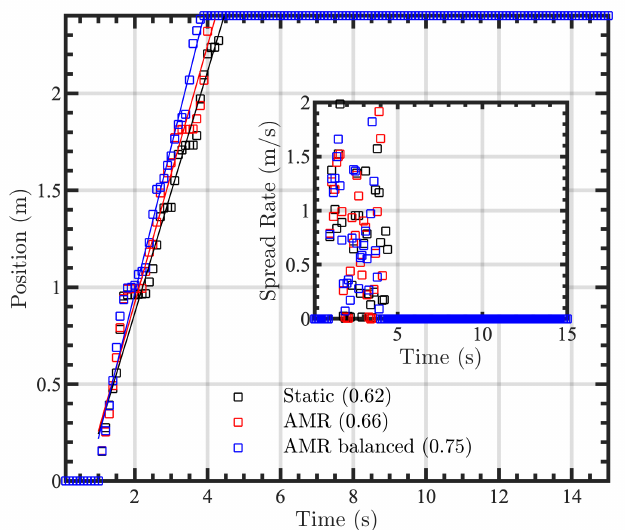
Figure 4. Comparison of fire spread and spread rate, shown in the inset as well as with least-squares fits, up the panel for the vertical fire spread verification test case in the static (black squares, black line), AMR without load balancing (red squares, red line), and AMR with load balancing (blue squares, blue line) simulations. The numbers in parentheses in the legend indicate the slopes of the least squares fits, giving an estimate of the spread rate in m/s for each case. Spread and spread rate were assessed from changes in char at the gas-solid